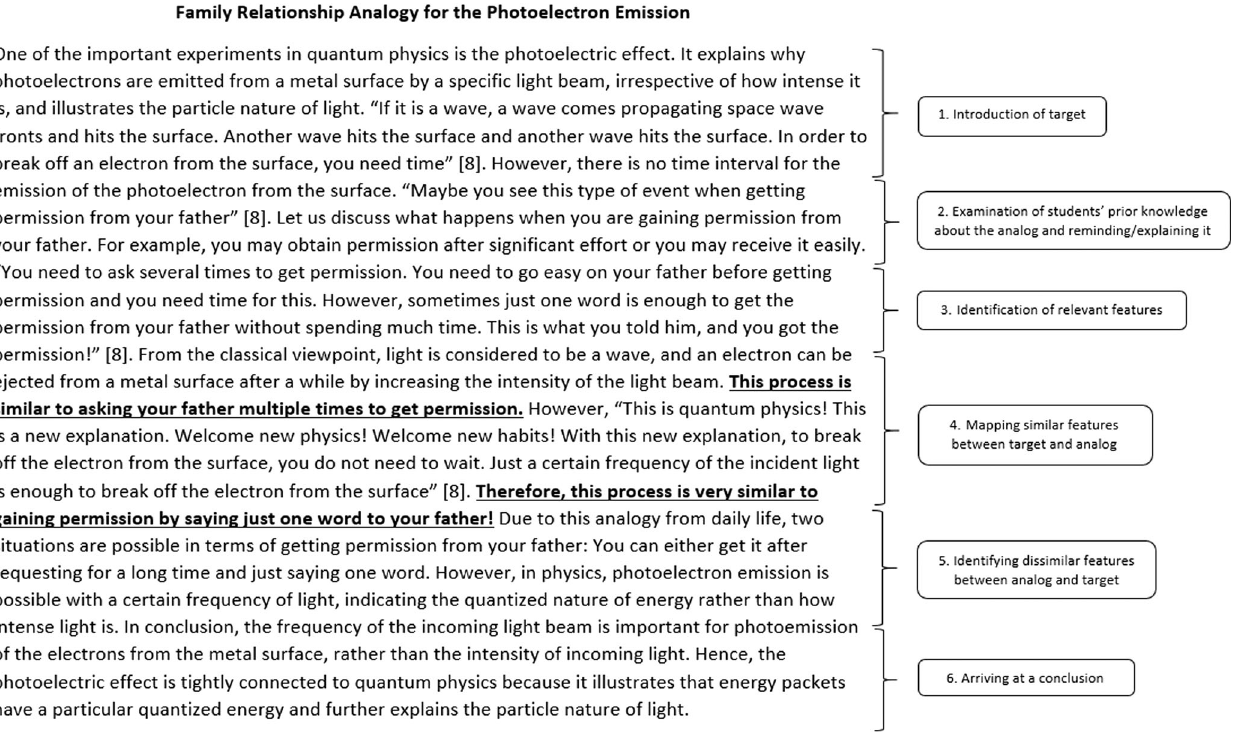
FIG. 1. An analogy with TWA steps for the photoelectron emission. This analogy, named the family relationship analogy, was originally presented in Didi ş ’ s [8] study investigating the analogies used in the teaching of introductory quantum theory. While the quoted parts were taken directly from Didi ş [8], a relevant text was added to improve the analogy by TWA